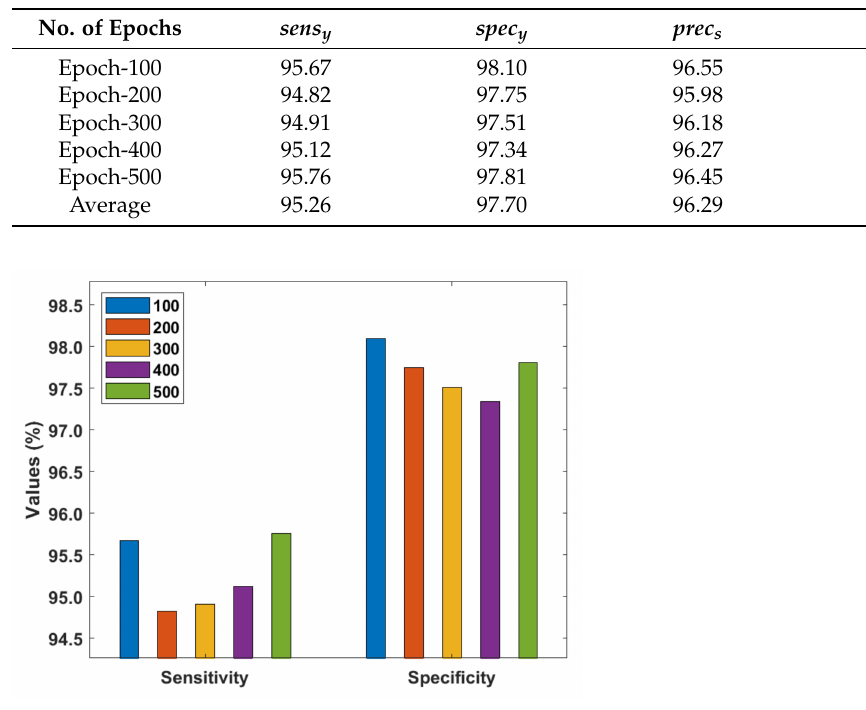
Table 1. Result analysis of the proposed DN-ELM method on various epoch sizes.